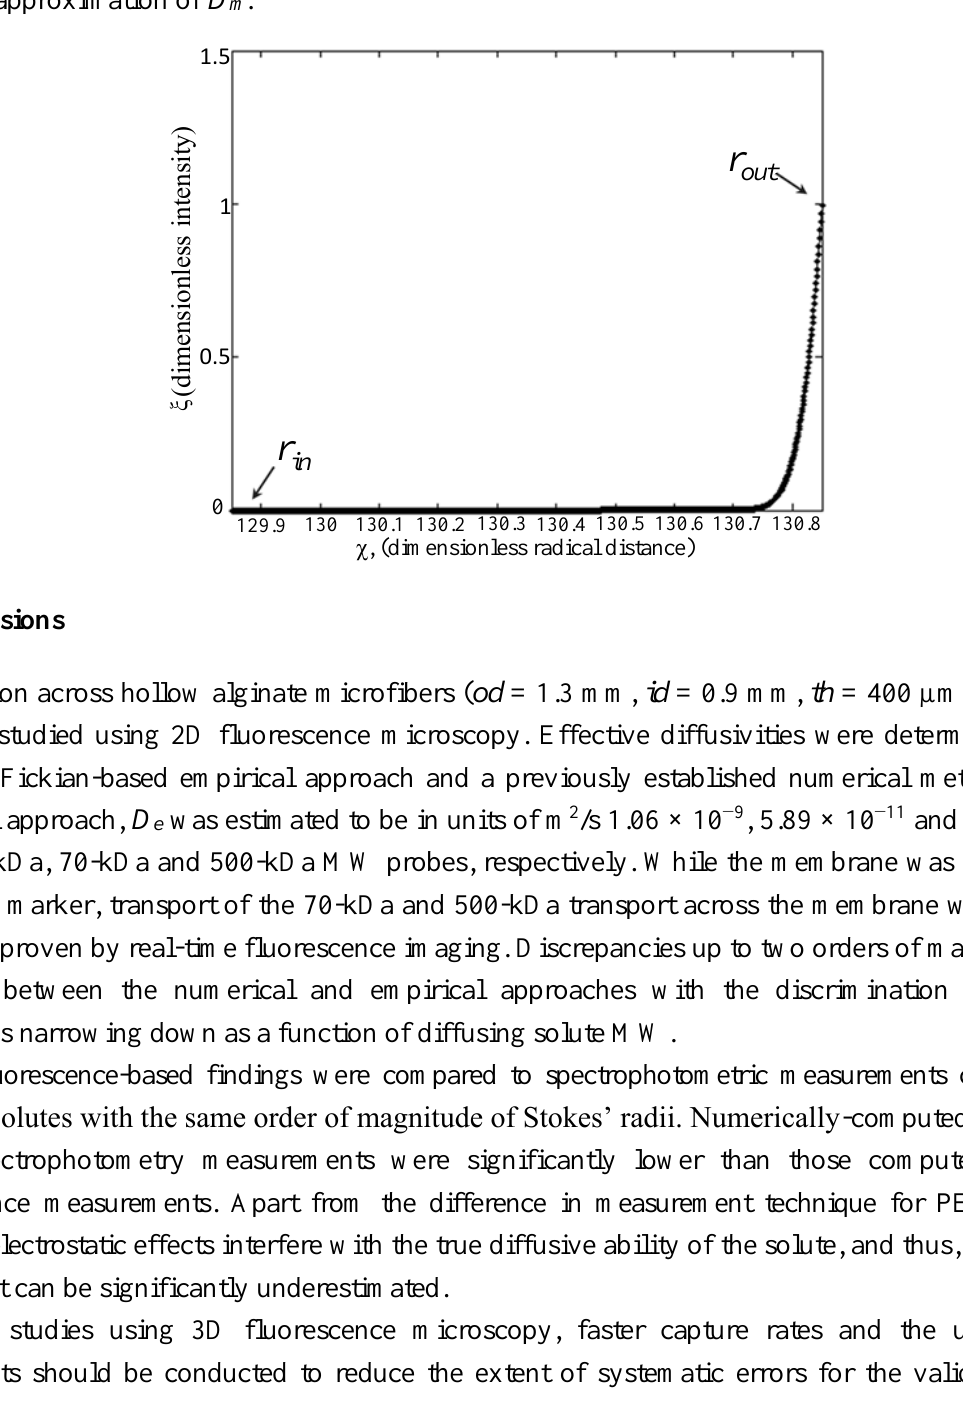
Figure 7. Sample dimensionless diffusion profile of FITC-dextrans, 4, 70 and 500 kDa for the approximation of D m